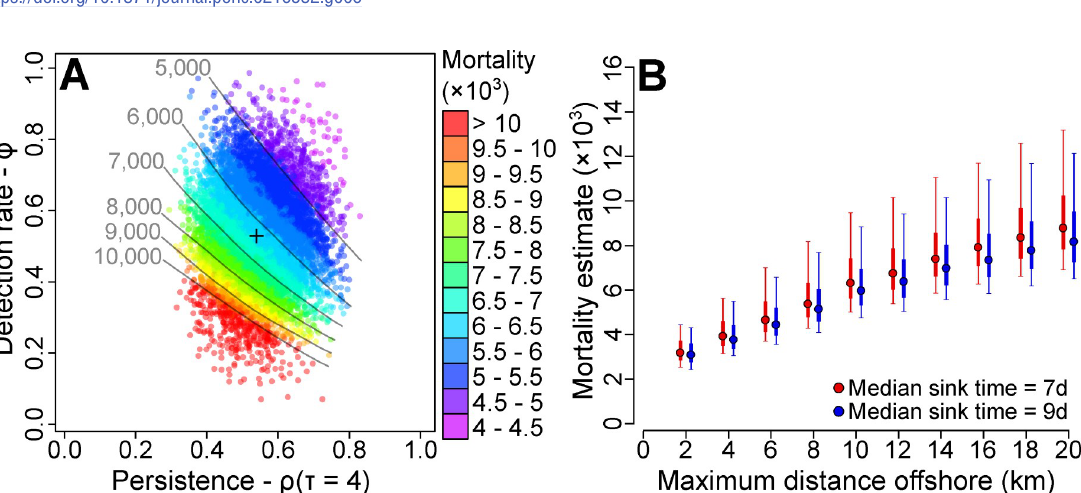
Fig 7. Total mortality estimates for a range of parameter estimates and distribution assumptions. Individual mortality estimates from a single model (A) run assuming moribund birds were distributed uniformly up to 10 km from St. Paul Island, and that carcasses remained afloat for 7 days on average, plotted as a function of detection and persistence rates that were randomly drawn for that model run. Contours represent equal mortality estimates for combinations of detection and persistence rate, and + represents the median value of persistence and detection rate. (B) Median estimates of total mortality for alternate scenarios of spatial distribution (uniform up to a maximum distance offshore of SPI) and float duration (median sink times of 7 and 9 days) plotted as a function of assumed distribution, with 50 (thick lines) and 95% (thin lines) confidence intervals calculated across random draws of persistence and detection rate within each modeled scenario.